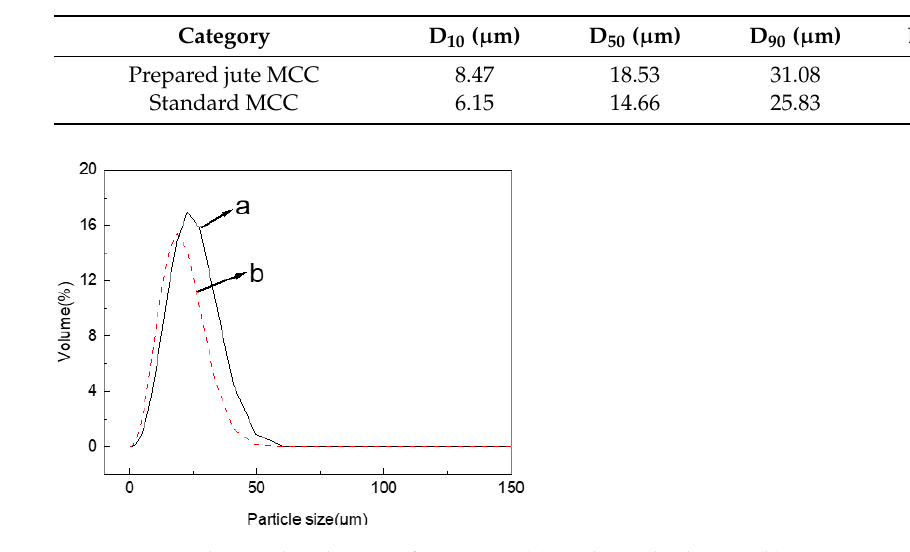
Figure 1. Particle size distribution of jute MCC (a), and standard MCC (b).